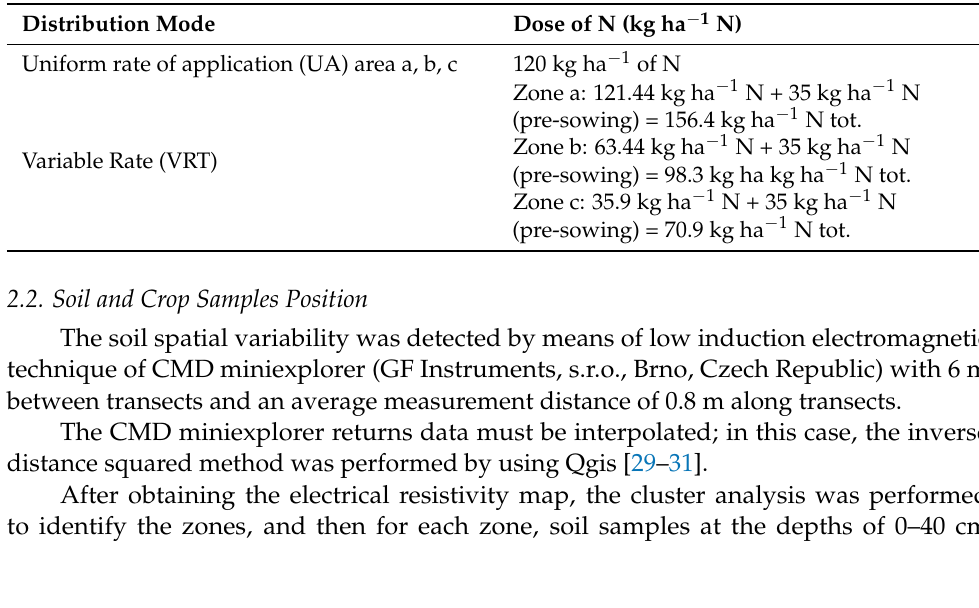
Table 2. Nitrogen management of site